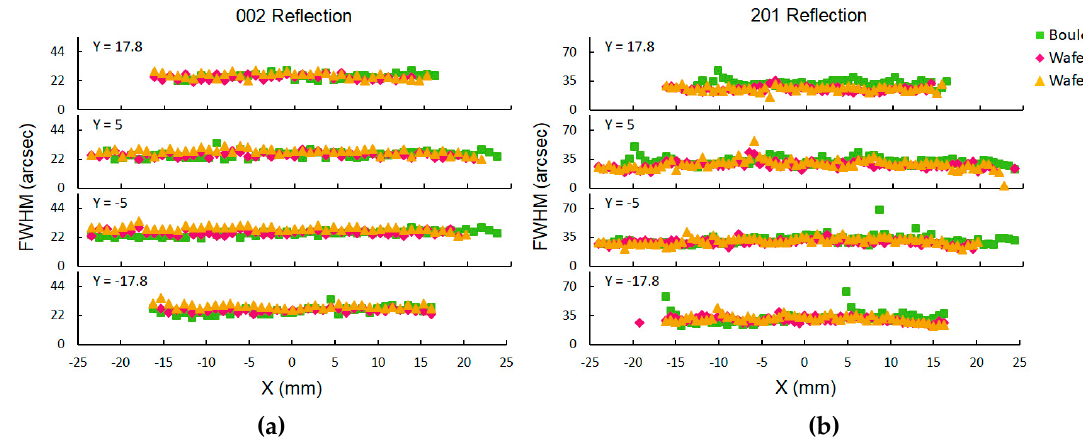
Figure 3. X-ray diffraction mapping of the 002 reflection FWHM (a) and the 201 reflection FWHM (b) . The radius of curvature ( 𝑅 (cid:3004) ) is calculated by looking at the difference in ω peak positions measured at two X positions on the crystal. Formula 1 is recognized as the inverse slope of the lines